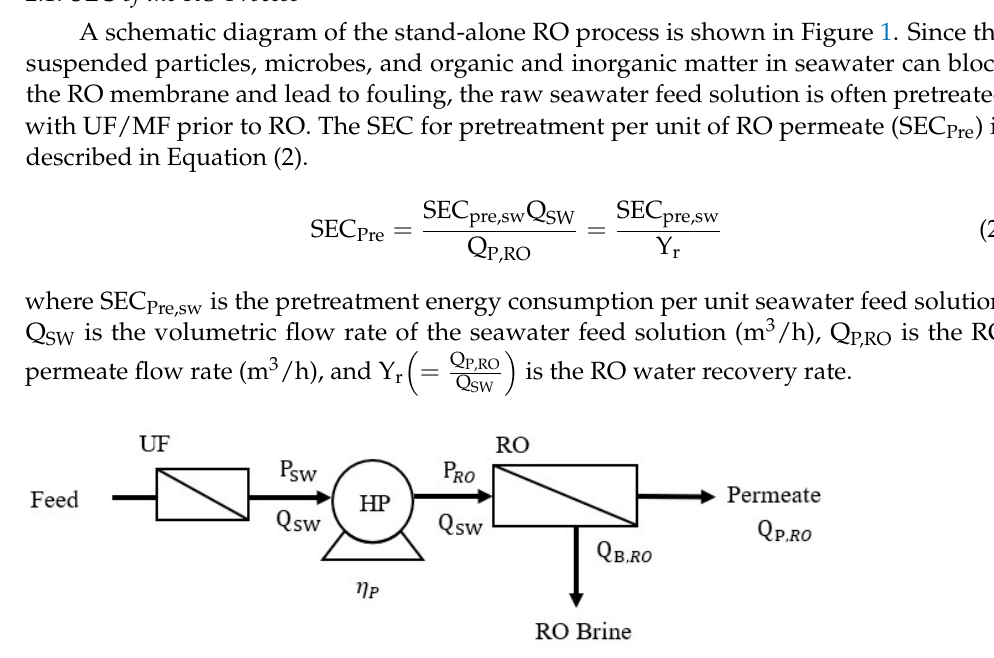
Figure 1. Schematic of the stand-alone RO